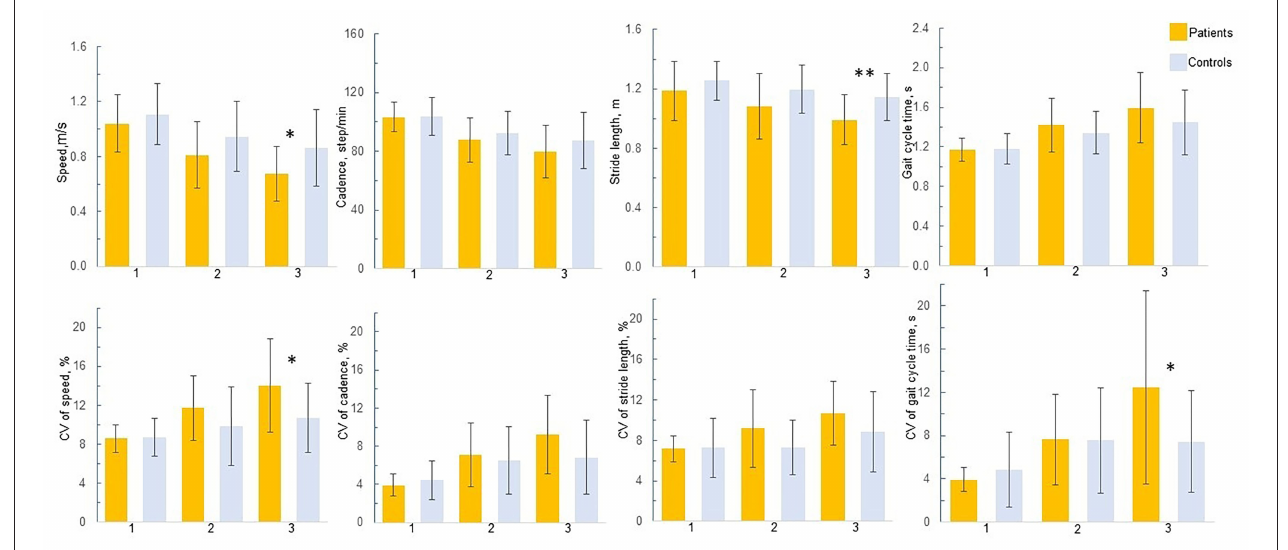
FIGURE 4 | Gait performance in patients and controls. 1 = Usual walking; 2 = Walking while counting forward; 3 = Walking while subtracting. * p < 0.05, ** p < 0.01; P -values adjusted for Bonferroni correction. Only significant between-group differences are presented in the figure.